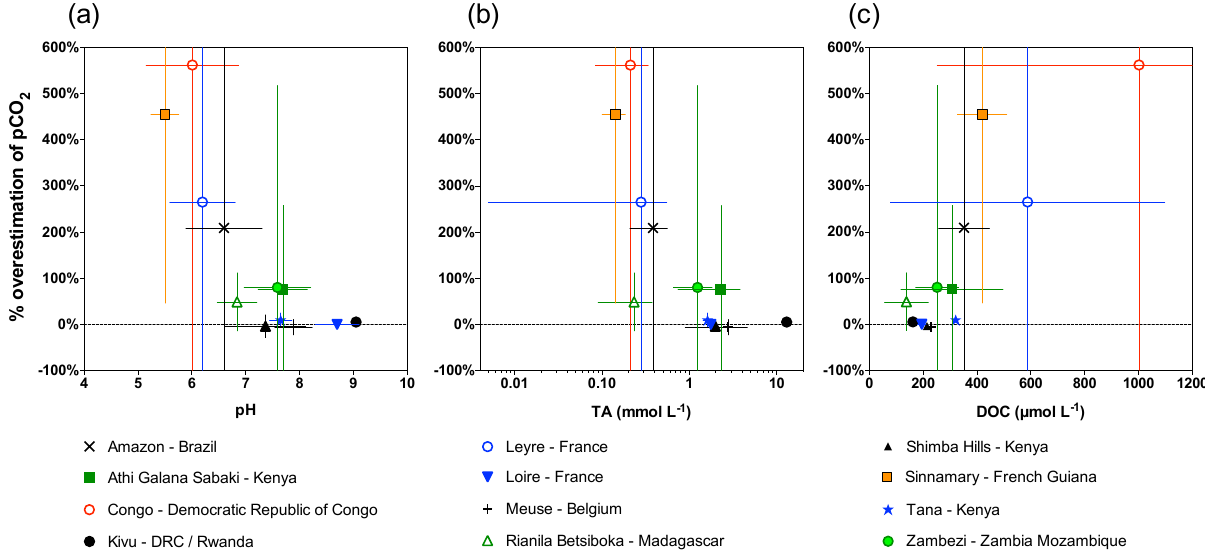
Figure 5. Average percentages of p CO 2 overestimation, calculated as 100 × (calculated p CO 2 – measured p CO 2 )/measured p CO 2 , as a function of (a) pH, (b) TA, and (c) DOC, for the 12 studied sites. Error bars indicate the standard deviation from the mean for each freshwater